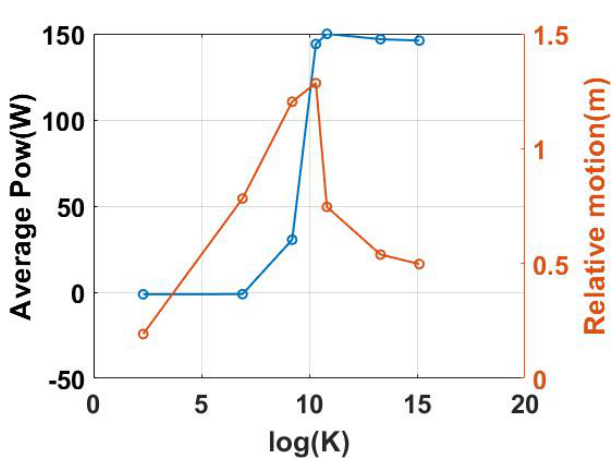
Fig. 2: The power extraction and the relative motion with different mooring stiffness K